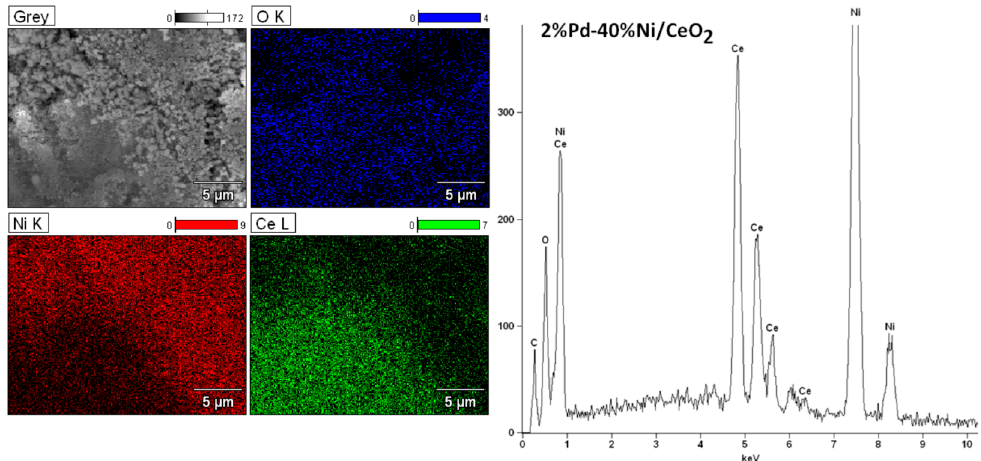
Figure 9. SEM images and EDS spectra for the bimetallic 2%Pd–40%Ni/CeO 2 catalysts calcined at 400 °C in air atmosphere for 4 h.